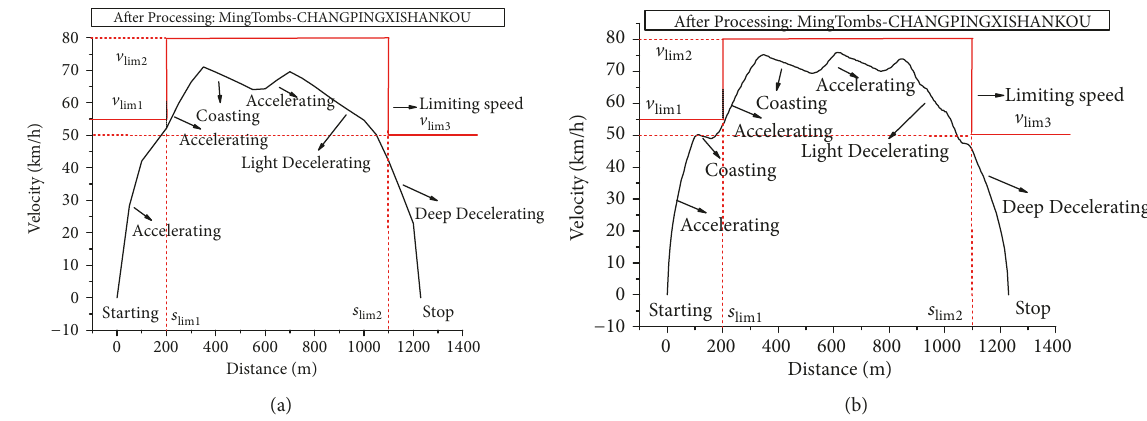
Figure 5: Profiles description at different distance intervals. (a) 50m interval. (b) 5m interval.